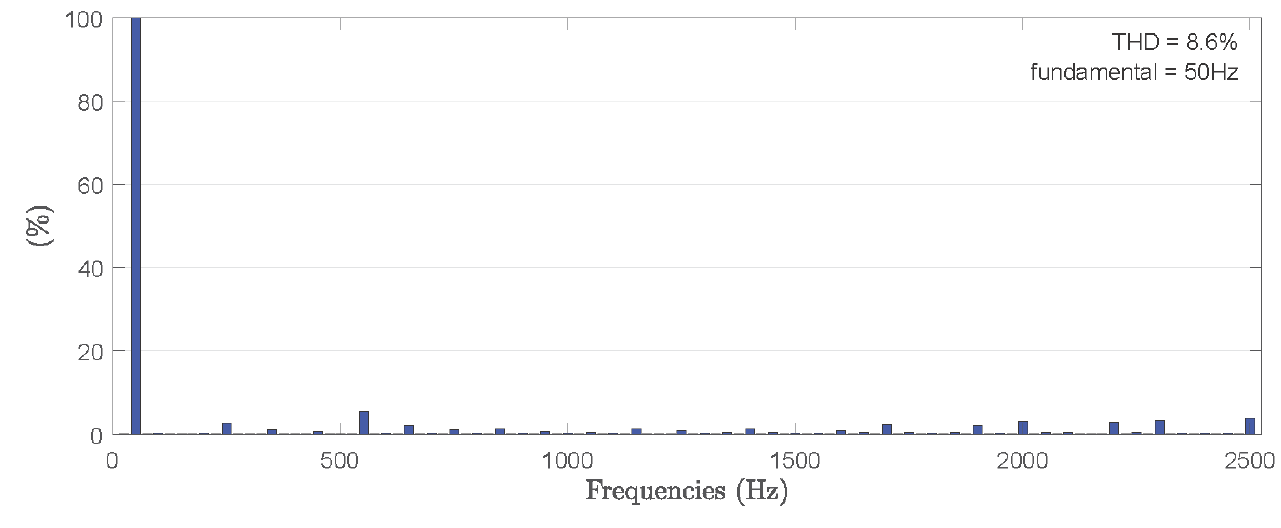
Energies 2022 , 15 , x FOR PEER REVIEW Figure 18. Voltage THD results using the grid analyzer. Figure 18. Voltage THD results using the grid analyzer.